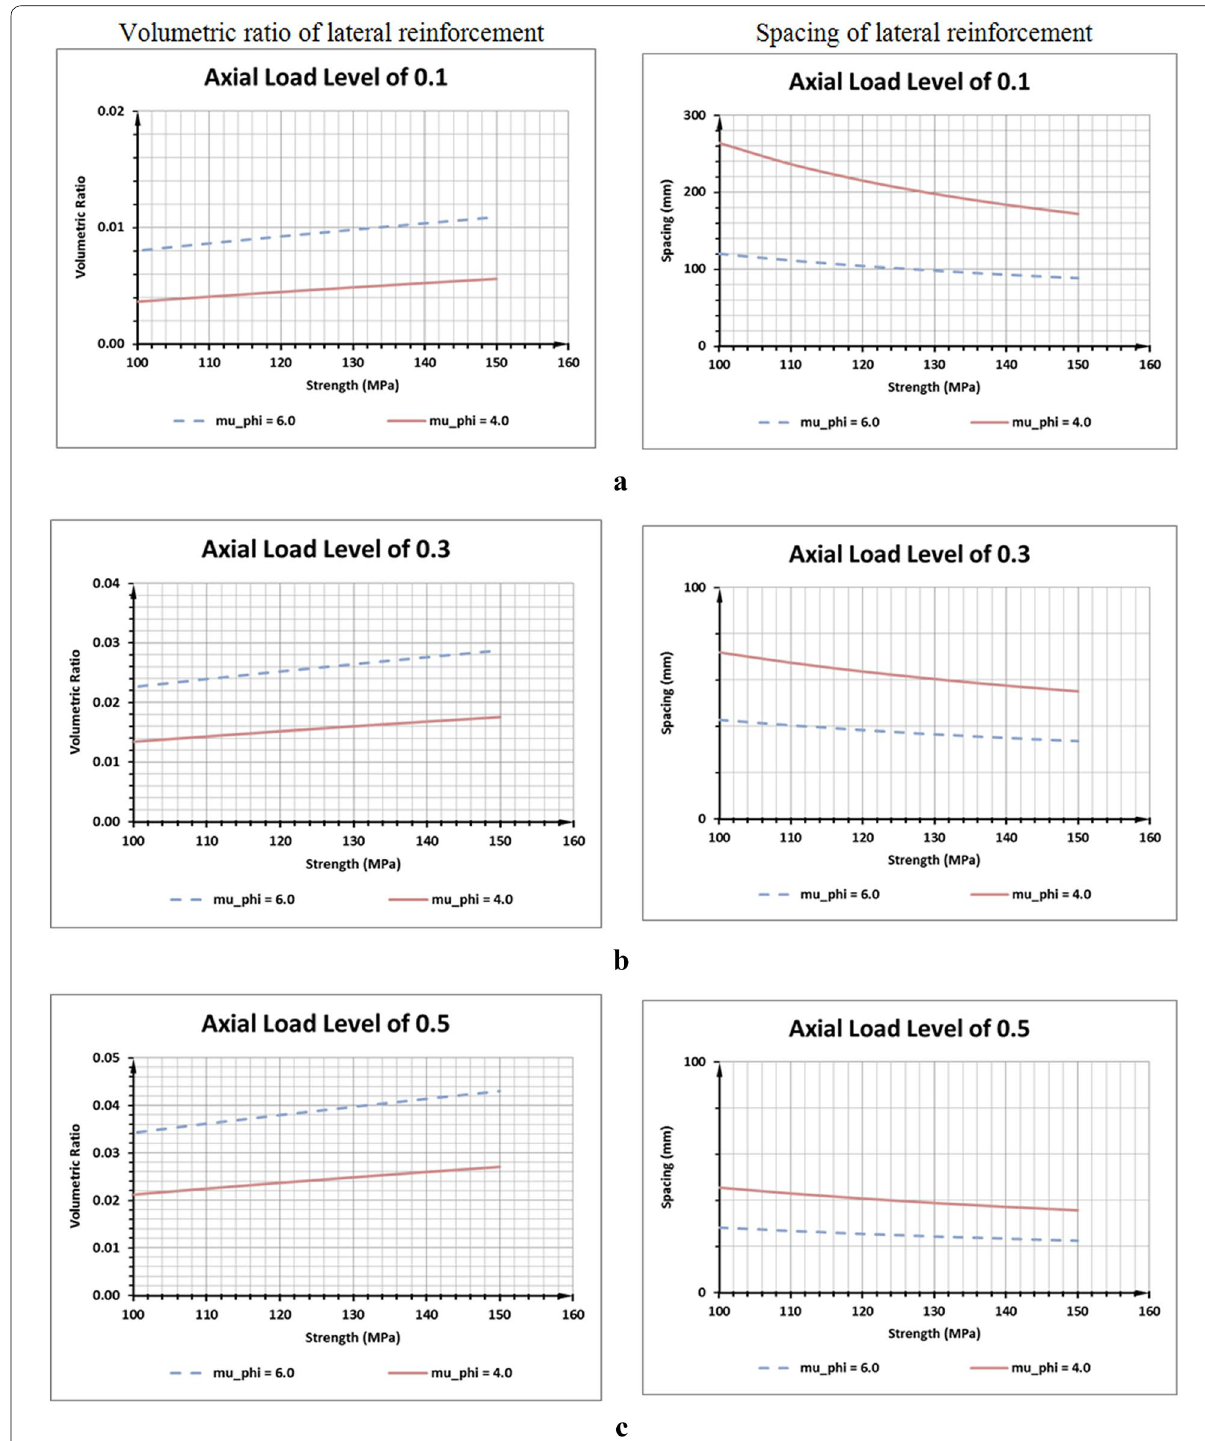
Fig. 11 Required volumetric ratio of transverse steel for different ductility levels ( µ φ P /f co A c 0.1, b P /f co A c =